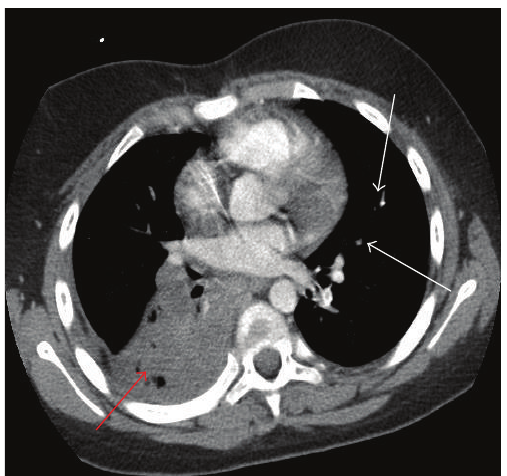
Figure 1: CT Chest with pulmonary angiogram. There is complete occlusion of the descending branch of the right pulmonary arteries totherightlowerlobe(Redarrow).Multiplesmallpulmonaryartery emboli were also seen in the left lobe (White